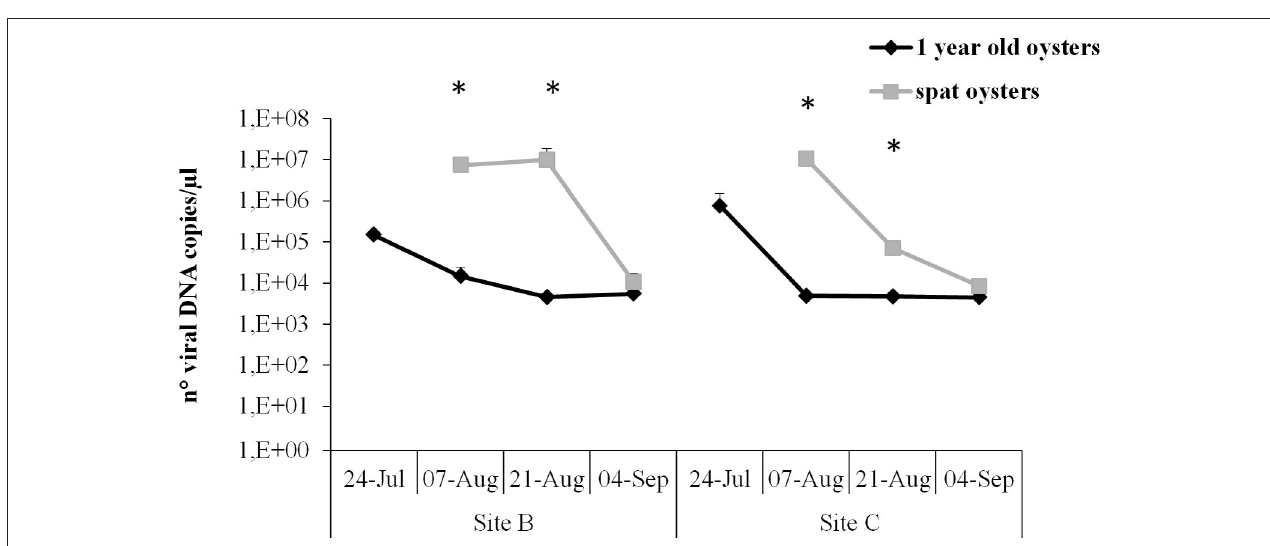
Frontiers in Physiology |